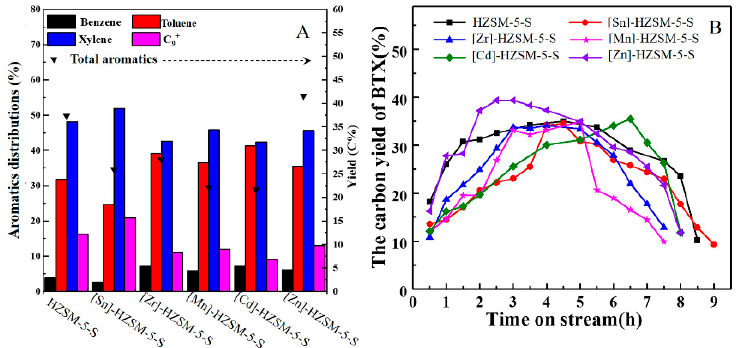
Figure 7. The yields and distribution of aromatics ( A ) and total carbon yield of BTX ( B ) obtained by [M]-HZSM-5-S.